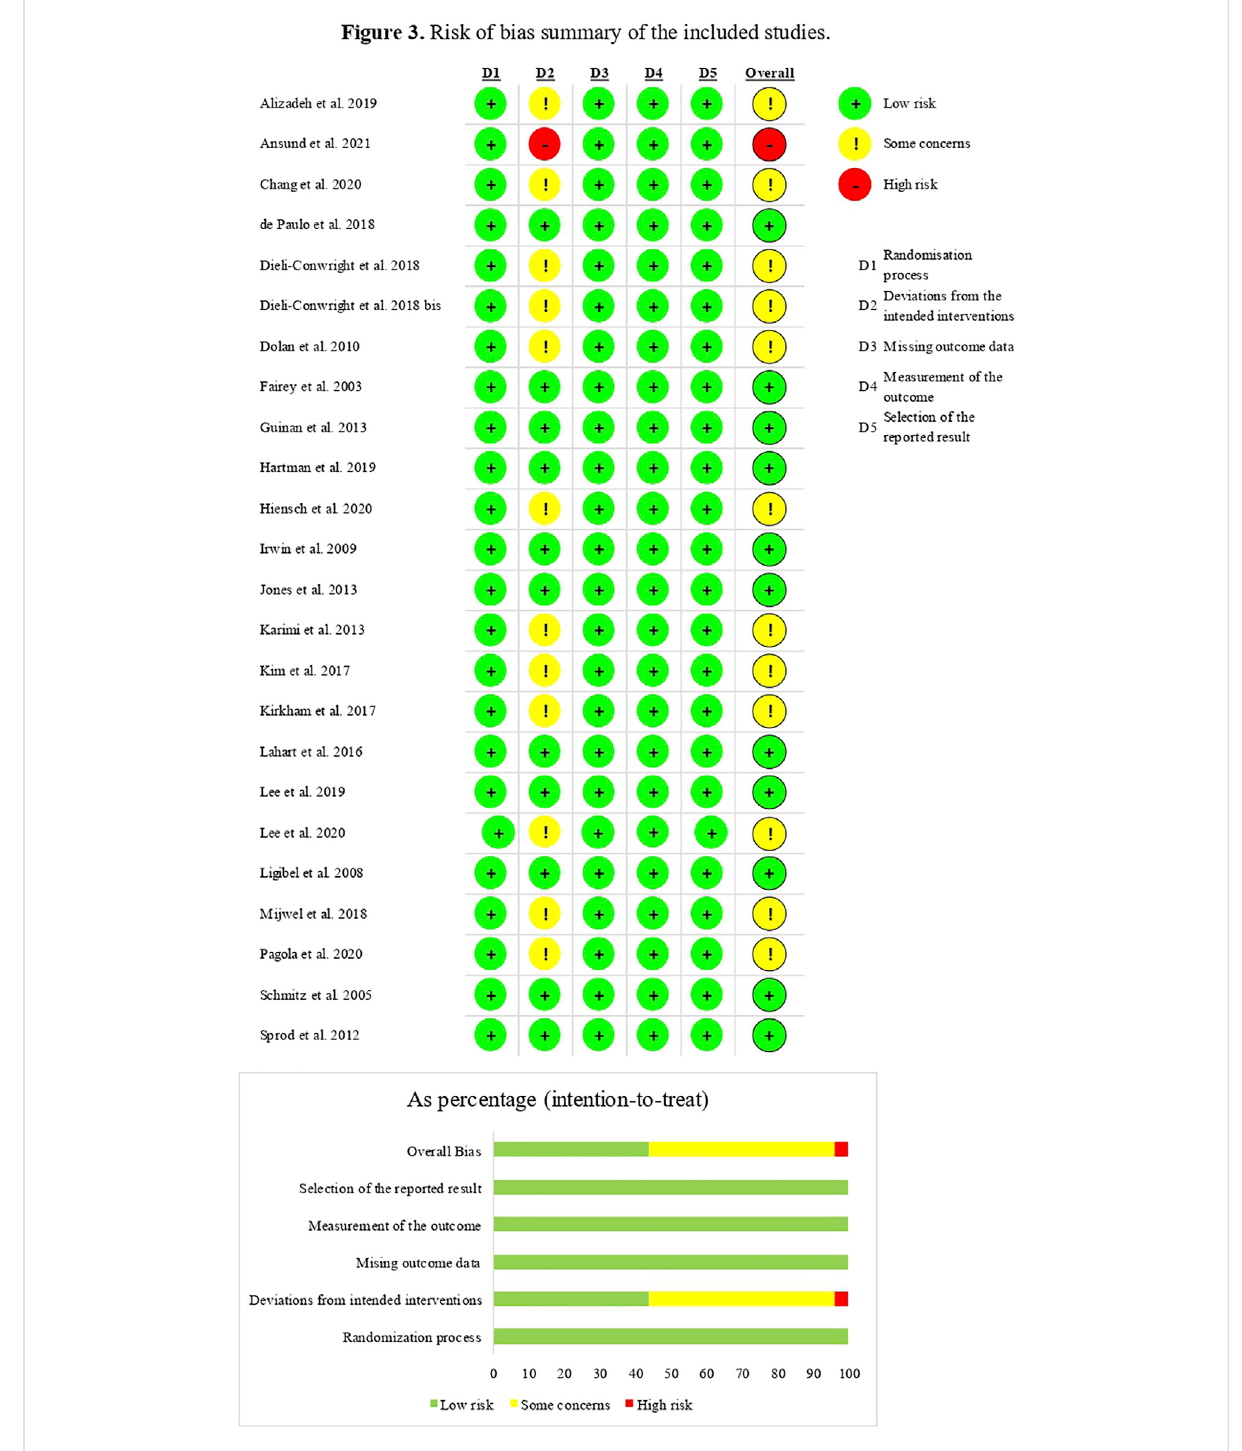
FIGURE 3 Risk of bias of the included studies according to the